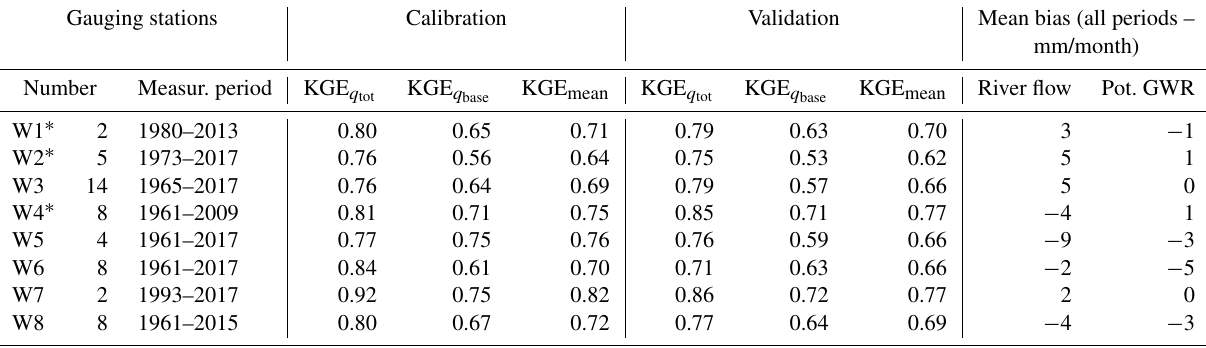
Table 3. Objective functions for the simulated outputs, for calibration and validation periods, and for mean bias over the entire period of measurement.